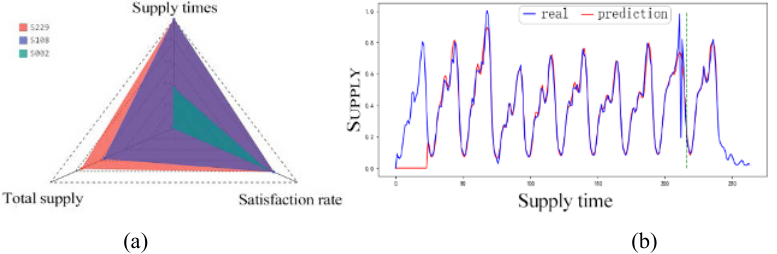
Fig. 3. Comparison of features indexes of some suppliers (a), Supplier data fitting effect